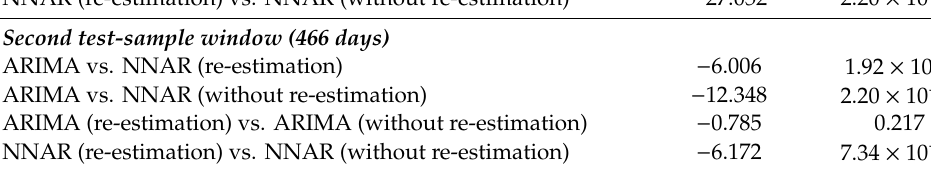
Table 4. DM test of forecast results.